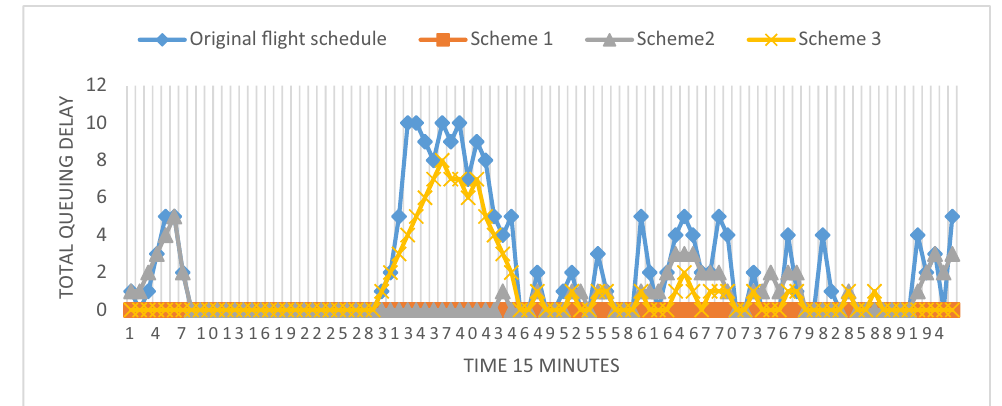
Figure 6: Flight queuing delays distribution in every 15 min of the optimized fl ight schedule by every scheme when δ 1 =